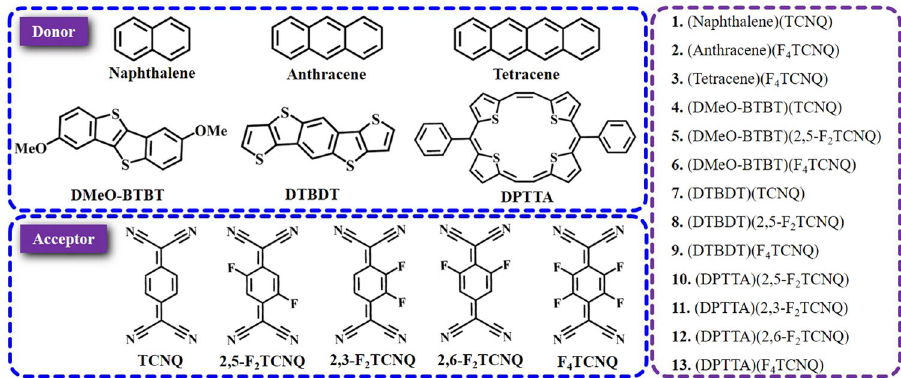
Fig. 1 Chemical structures of our studied six donor molecules and fi ve acceptor molecules. The number and abbreviation of our studied 13 organic donor – acceptor complexes are also displayed in the fi gure. Their full name, source of crystallographic structures, and lattice parameters are shown in Supplementary Table 1 and their crystalline structures are displayed in Supplementary Fig.